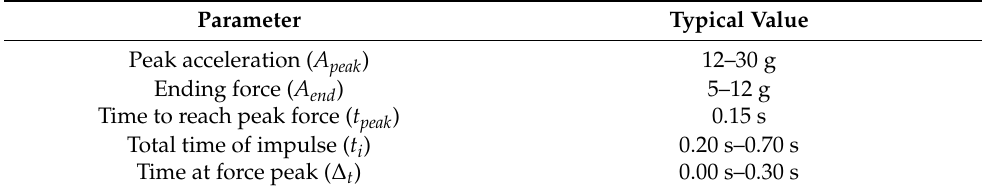
Table 1. Variables values for the trapezoidal acceleration